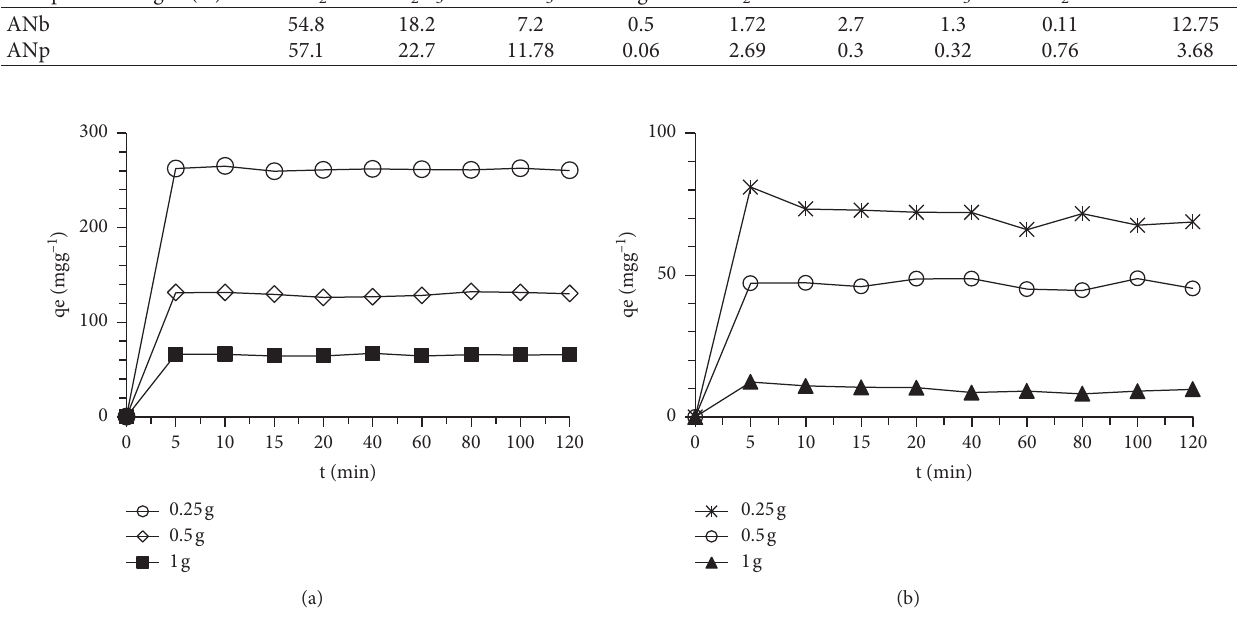
Figure 1: Effect of adsorbent dose and contact time on raw (a) and purified (b) clays.